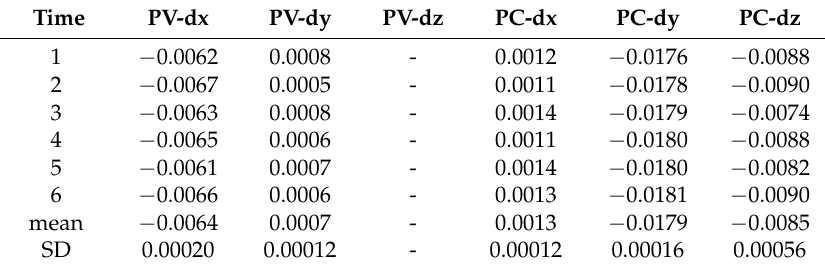
Table 7. Offsets between sensors with a sphere unit (unit: